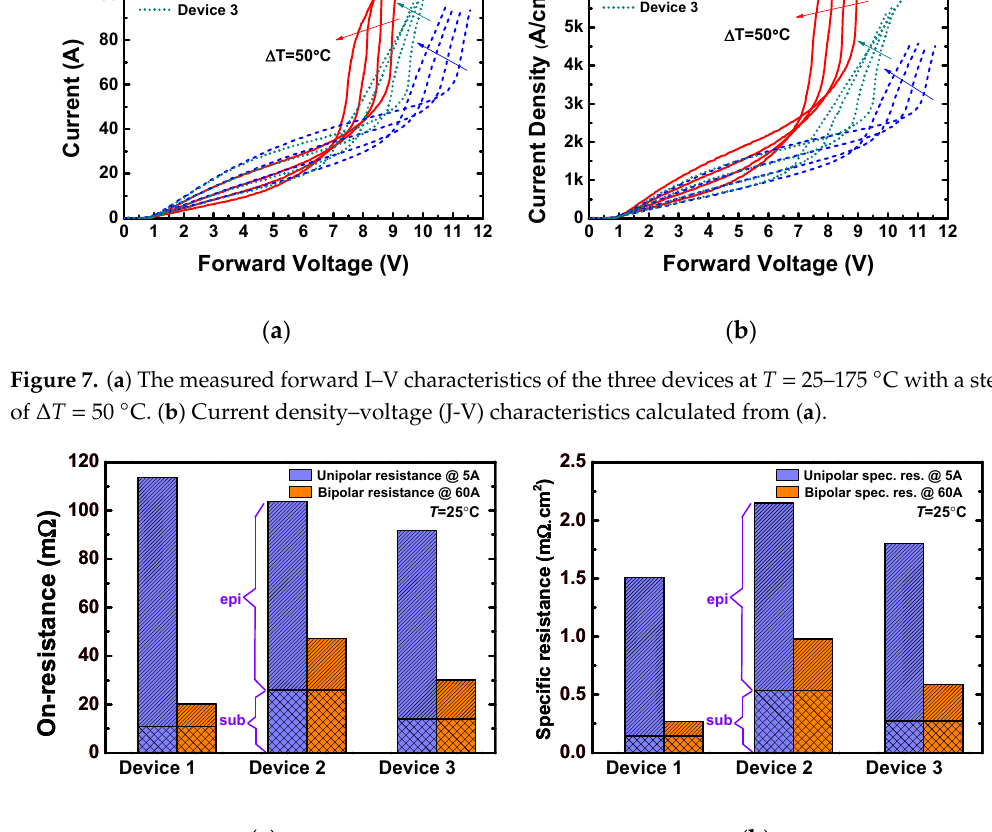
( b ) Figure 9. (a) Voltage waveforms and (b) I–V trajectories of Device 1 during the surge current tests.